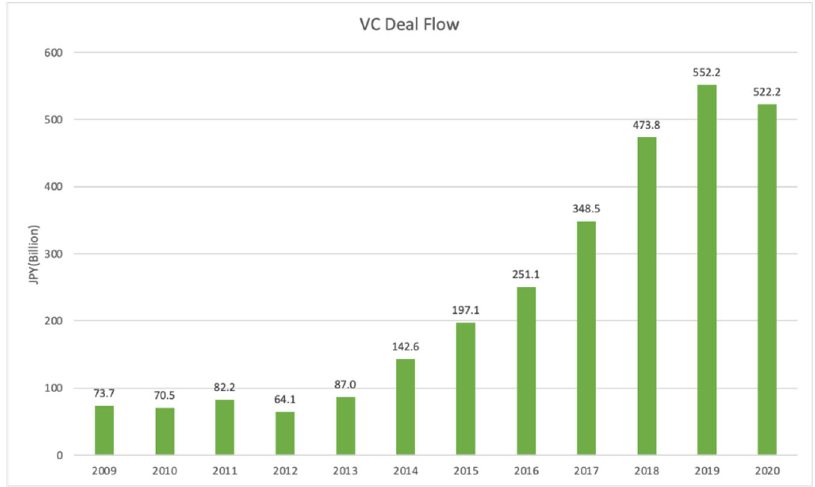
Figure 2. Total amount of VC deal flow in Japan Source: INITIAL